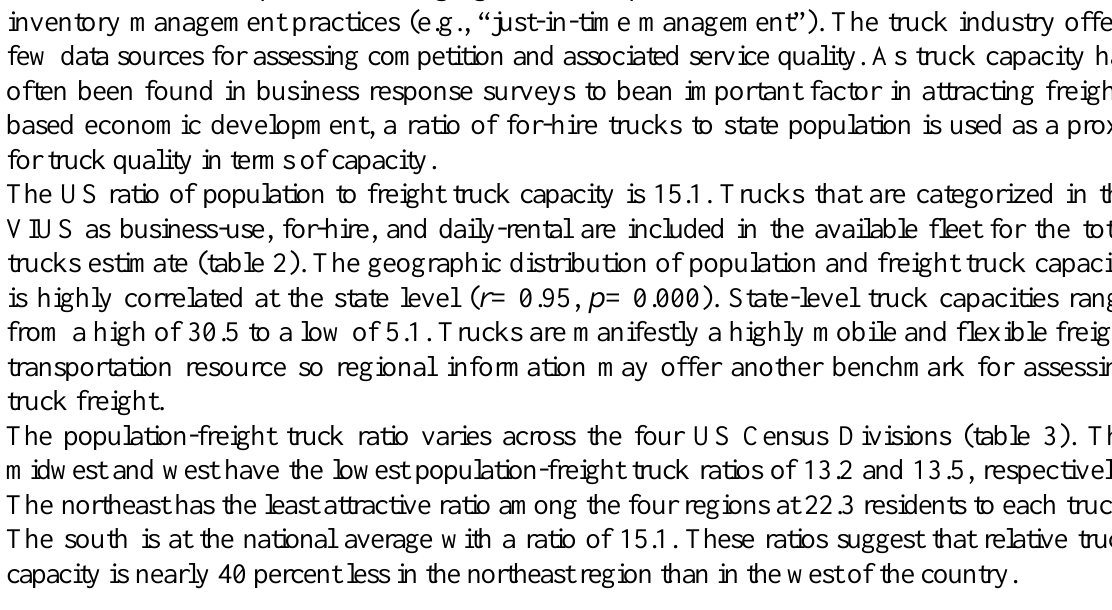
Table 3. US Population-to-truck